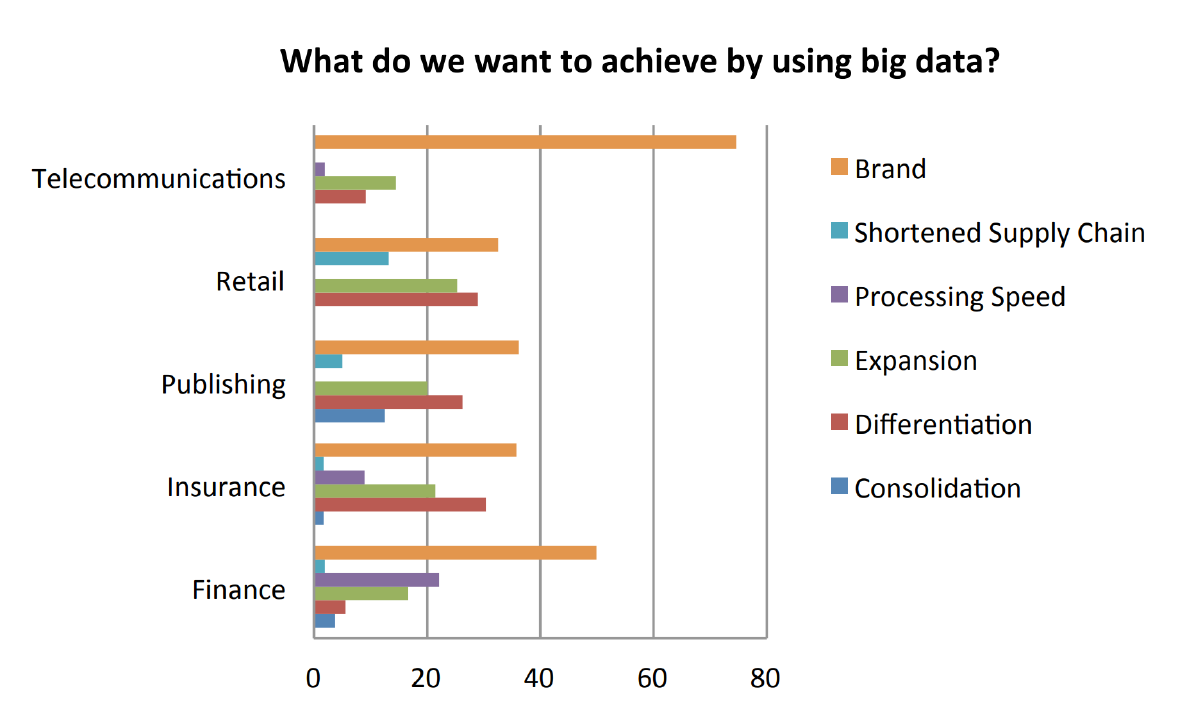
Figure 2: Goals for Big data